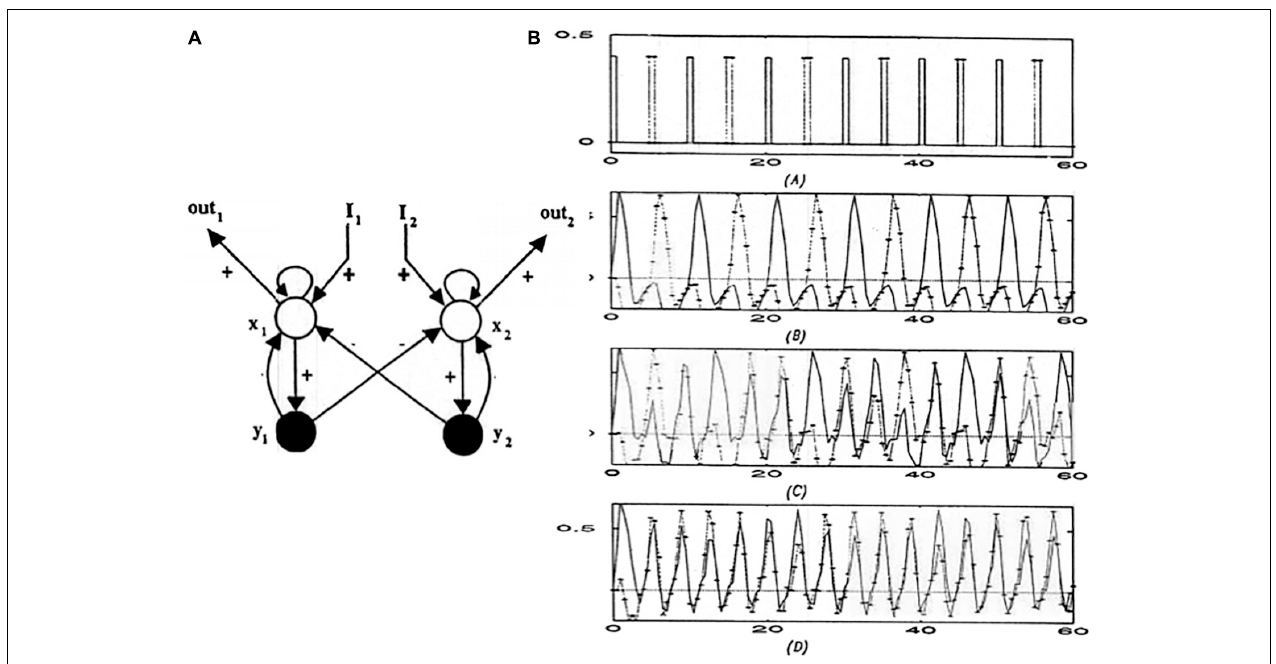
FIGURE 14 | A recurrent shunting on-center off-surround network models data about synchronization of bimanual tapping. Bifurcation from anti-phase to in-phase oscillation occurs in response to anti-phase inputs of increasing frequency. See the text for details. [Reprinted from Grossberg et al. (1997b)].